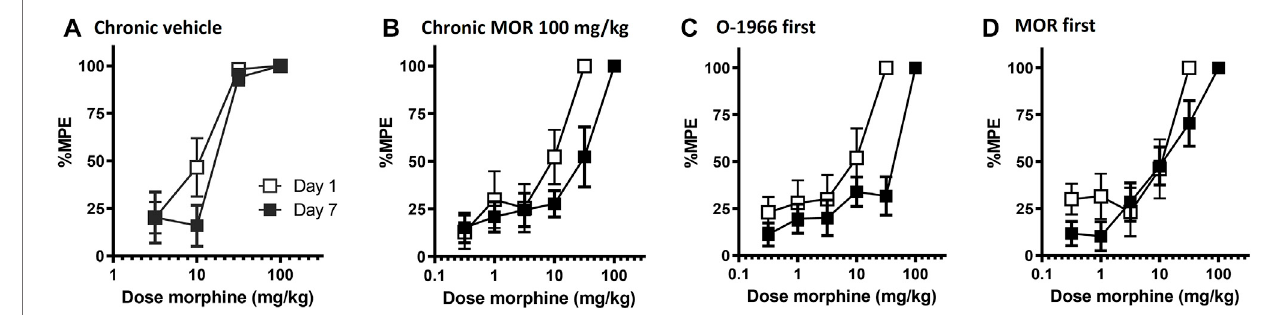
FIGURE 4 | Effect of chronic dosing regimens of vehicle (A) , morphine (B) , O-1966 (data shown in Table 2 ), and morphine + O-1966 (C,D) on development of morphine antinociceptive tolerance. X -axis: Cumulative dose of morphine in mg/kg. Y -axis: antinociception as percent maximum possible effect. Each data point represents the mean (±S.E.M.) from eight mice. Open squares represent morphine antinociceptive effect on Day 1, and closed squared represent morphine antinociceptive effect in the same mice on Day 7 following a 5 day chronic dosing regimen. Titles above the graphs describe agents administered during the 5 day dosing regimen. In groups that received morphine and O-1966 during the dosing regimen, drugs were given 15 min apart.